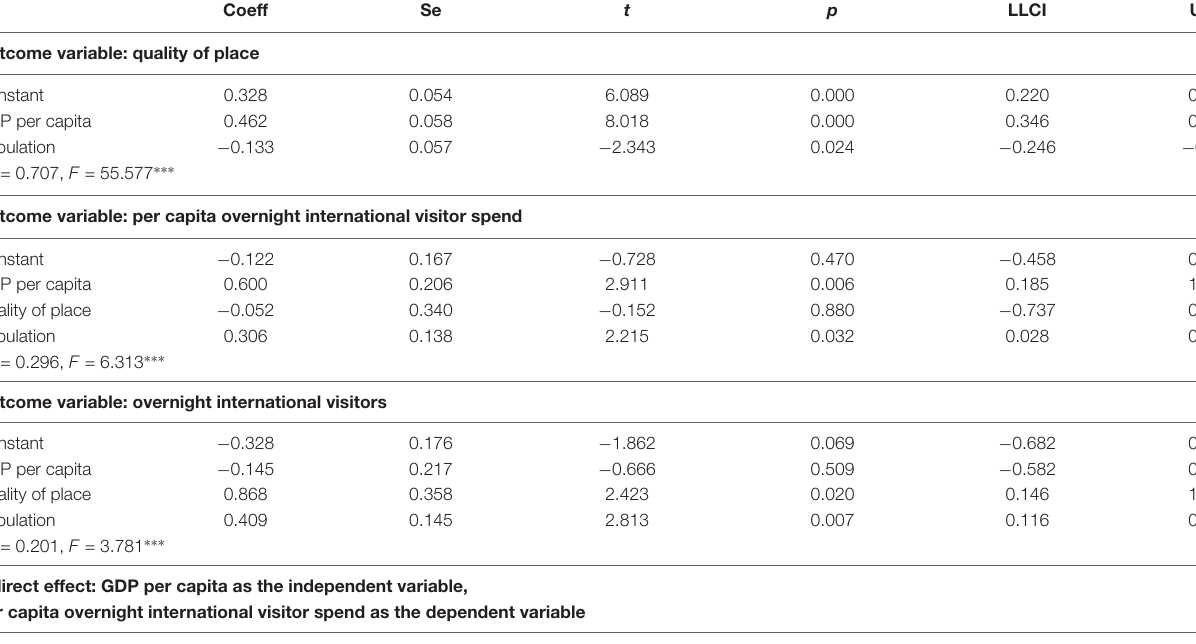
TABLE 3 | Results for mediation